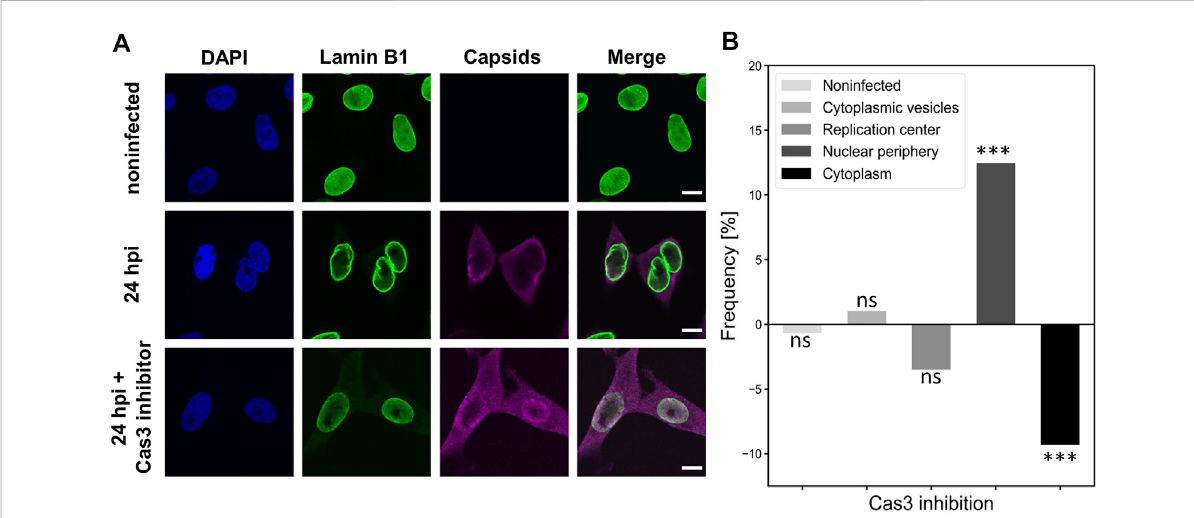
FIGURE 8 Caspase 3 inhibition leads to decreased nuclear egress of capsids (A) Non-infected and infected NLFK cells in the absence and the presence of caspase 3inhibitorat 24 hpi. The cells were immunolabeled with antibodiesagainstlaminB1 (green), intact capsids (magenta) and bluecorresponds toDAPIstaining.Scalebars,25 µm. (B) Intracellularlocalizationofcapsidsinnon-treatedandcaspase3treatedinfectedcells.Fivecapsidlocalization classes described in Figure 6A are shown. The horizontal line at value 0 shows capsid distribution in untreated infected cells, and positive and negative values represent inhibitor-induced increase and decrease in the speci fi c localization of capsids. Signi fi cant differences tested with the chi- square test are denoted as *** ( p < 0.001), and non-signi fi cant as ns ( p >